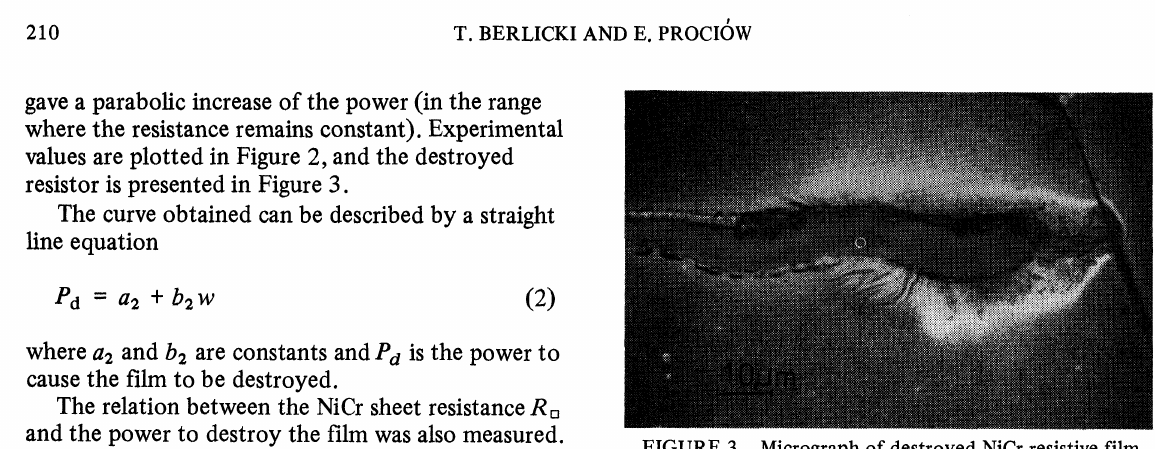
FIGURE 3 Micrograph of destroyed NiCr resistive film.